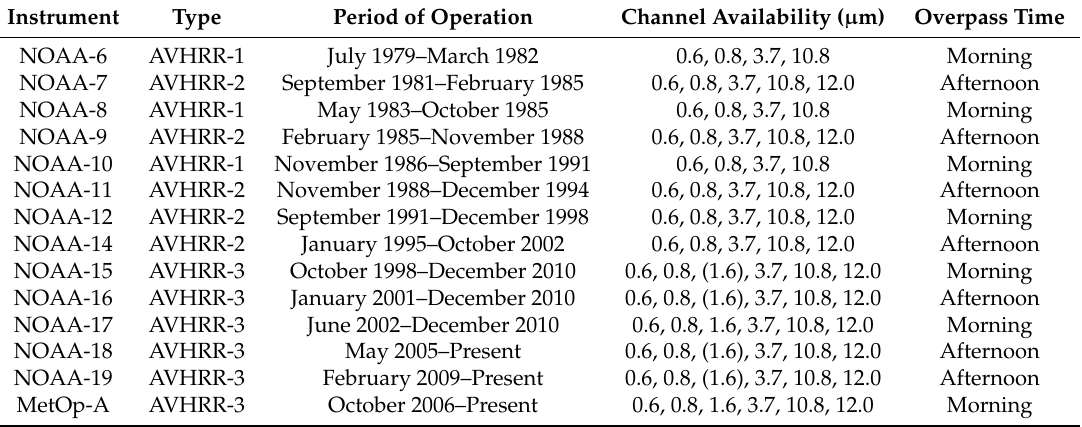
Table 1. AVHRR instrument record indicating instrument name and type, period of operation, channel availability and daytime equator overpass time. Parenthesis around a given channel indicates that data from that channel are not routinely